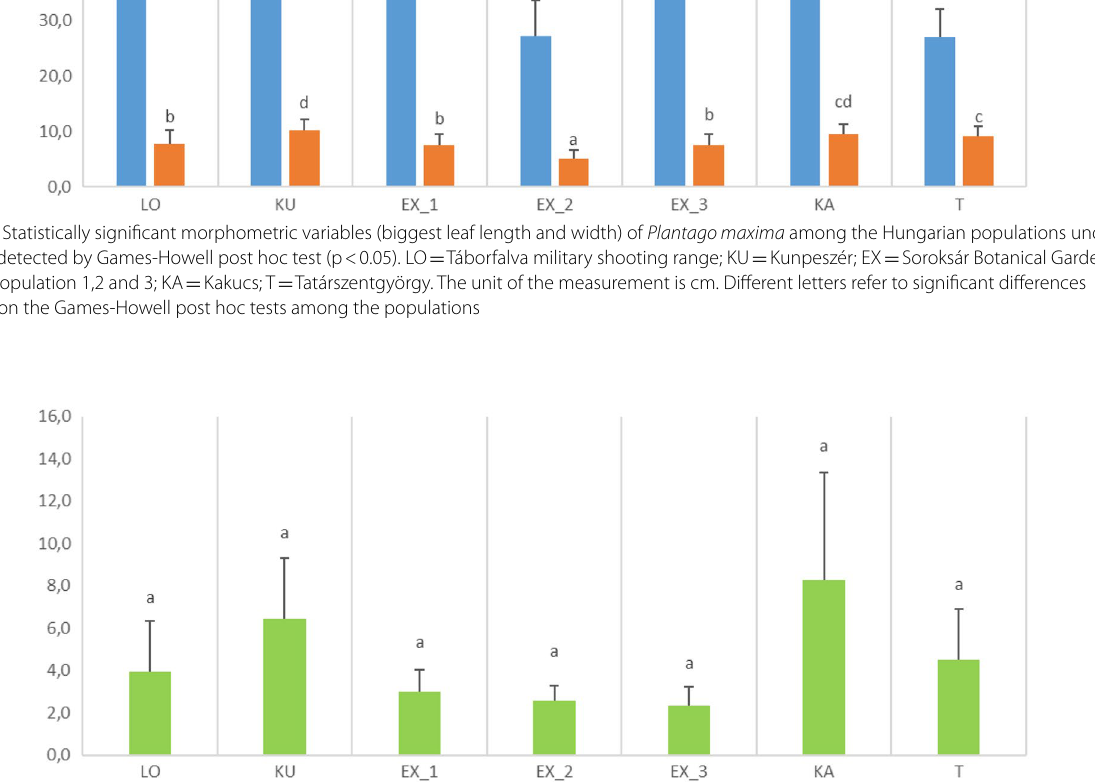
Táborfalva military shooting range; KU =